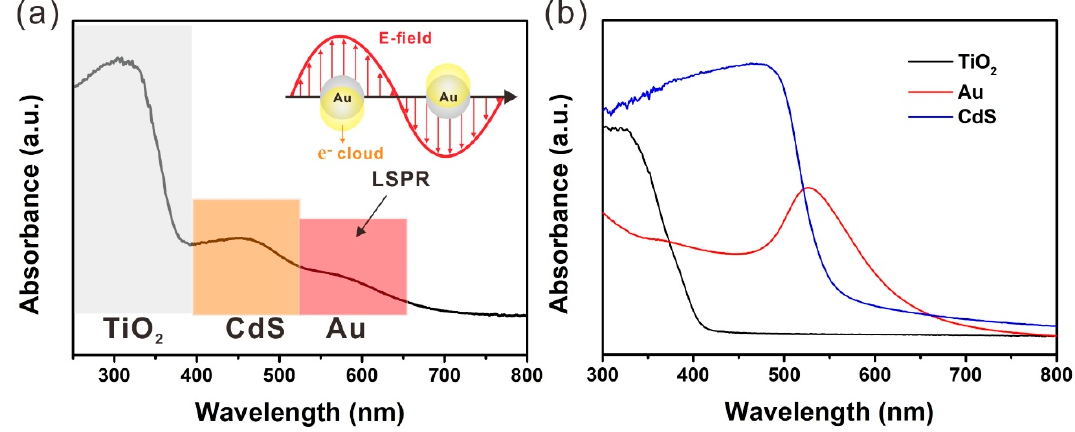
Figure 4. UV-vis light apparent absorbance spectrum of ( a ) 3DOM TiO 2 -Au-CdS and ( b ) individual TiO 2 , Au, and CdS.